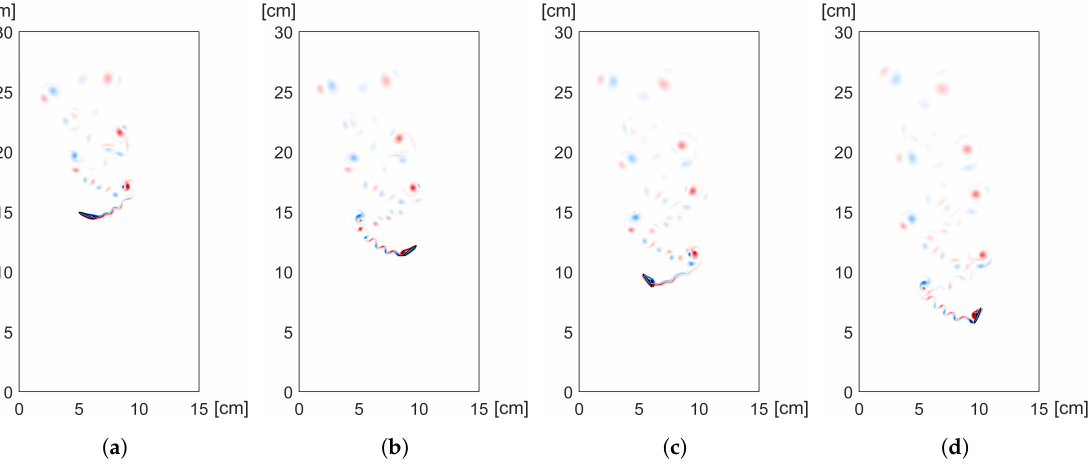
Figure 9. Wake structure in vorticity contours at time ( a ) t = 2.5 s ( b ) t = 3 s, ( c ) t = 3.5 s, and ( d ) t = 4 s. This corresponds to the fluttering mode in Figure